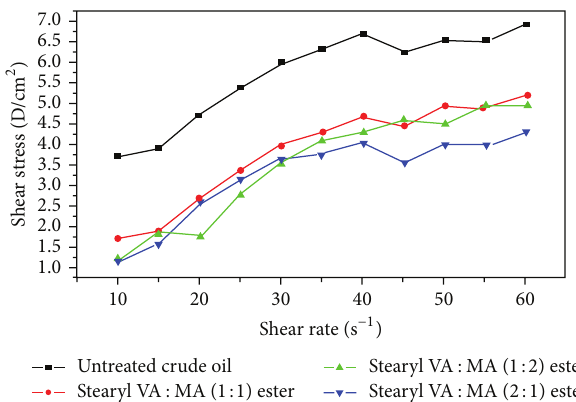
Figure 6: Rheogram of untreated and treated crude oil with 5000 ppm of different mol ratios at 12 ∘ C.